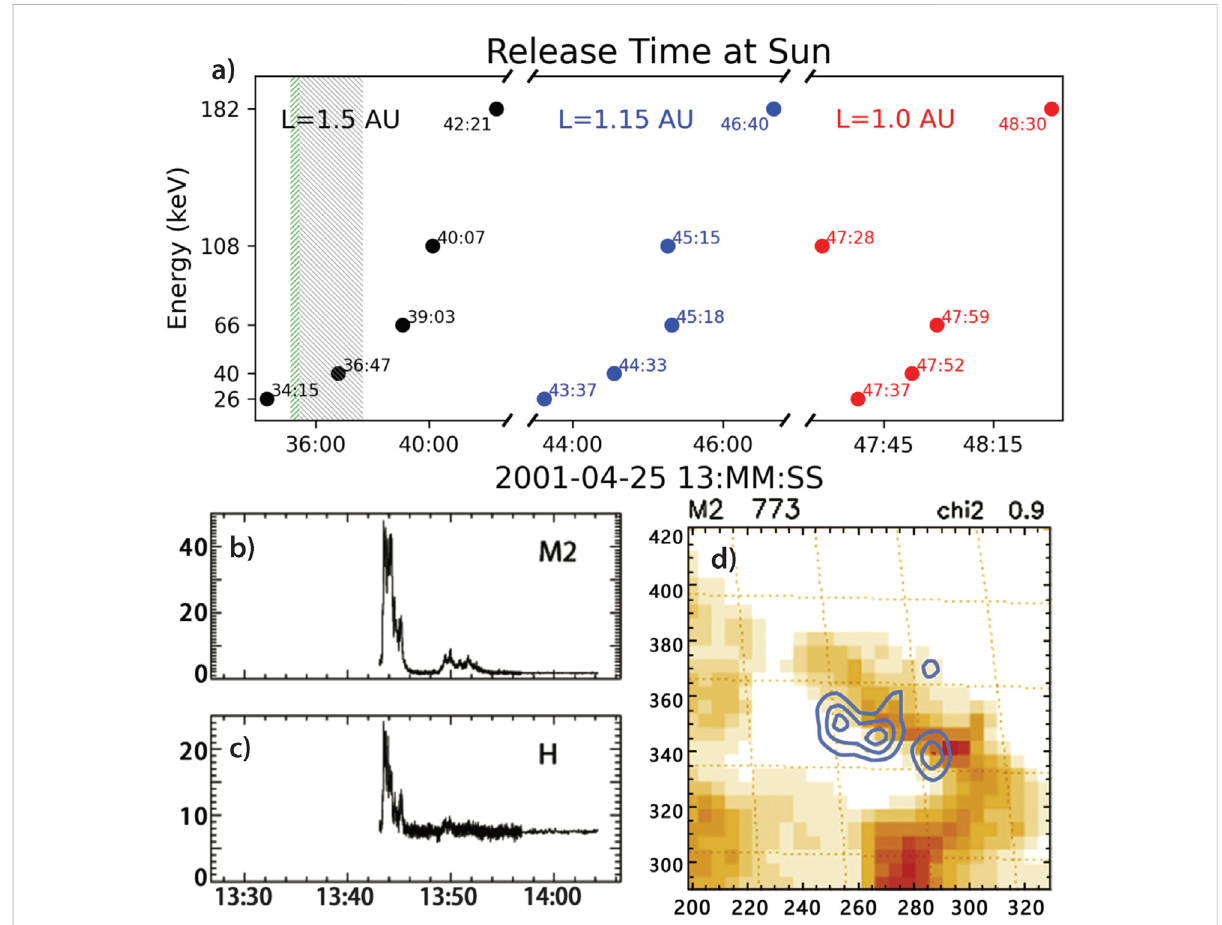
FIGURE 5 (A) Release times of energetic electrons for various path lengths and energies (dots) with onset-to-peak (peak-to-end) phases of hard X-rays represented by the green and grey dashed regions. (B,C,D) Yohkoh/HXT hard X-ray observations of the fl are related to the energetic electron observations with red contouring (D) from GOES soft X-ray. Adapted from Li et al. (2020). Comparisons between multi-point observations of hard X-ray and energetic electrons are needed to constrain coronal